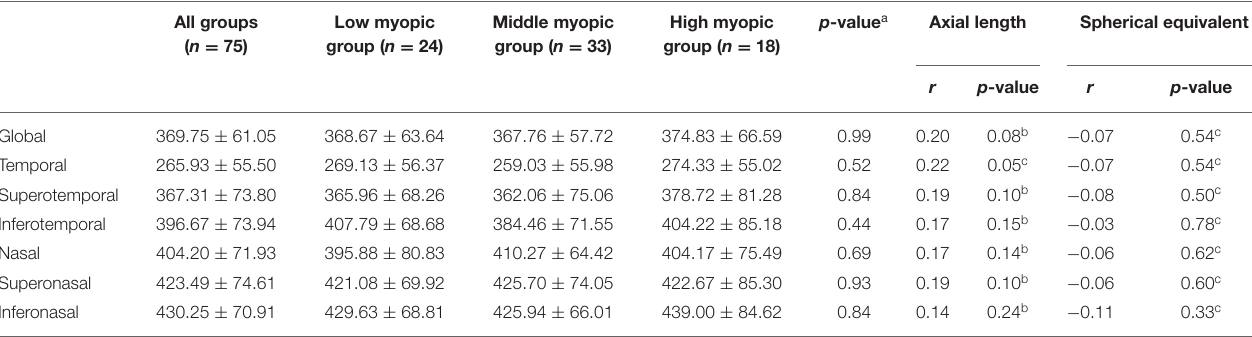
TABLE 2 | Correlations between Bruch’s membrane opening-minimum rim width and axial length/spherical